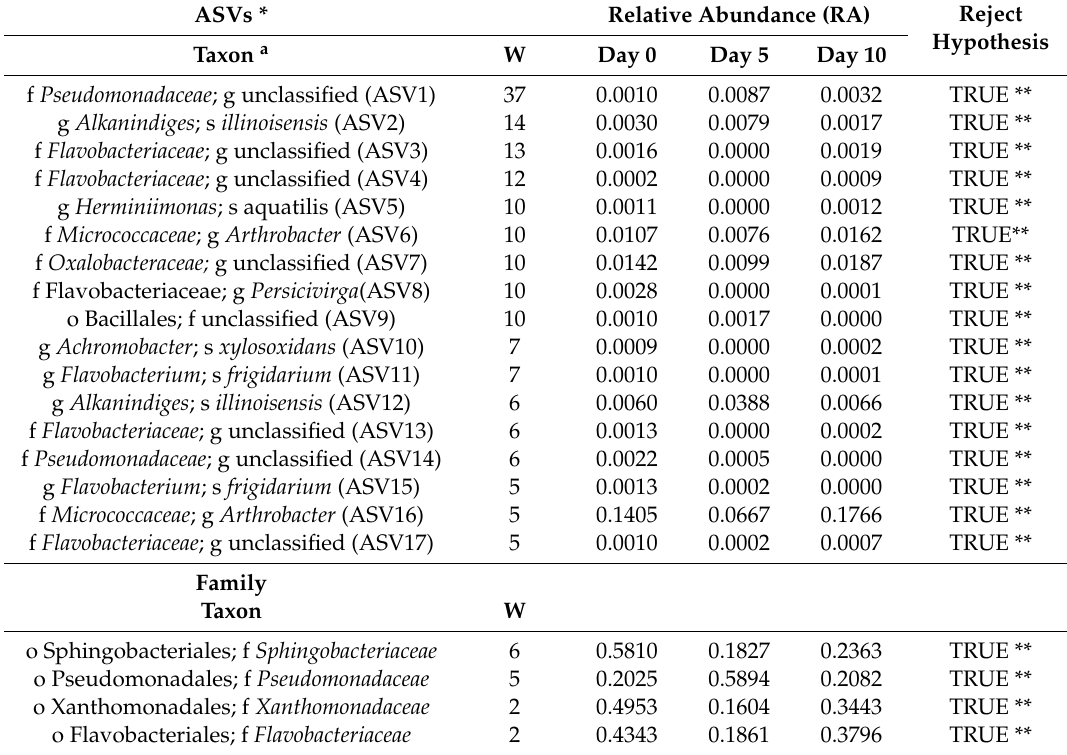
Table 4. Taxa (17 ASVs) and genera (5 genera) identified as significantly di ff erent in abundance on sampling days 0, 5 and 10 by analysis of composition of microbiomes (ANCOM) analysis at a false discovery rate (FDR) of 0.05. The higher the W value, the more significant are the di ff erences in abundance levels between the sampling